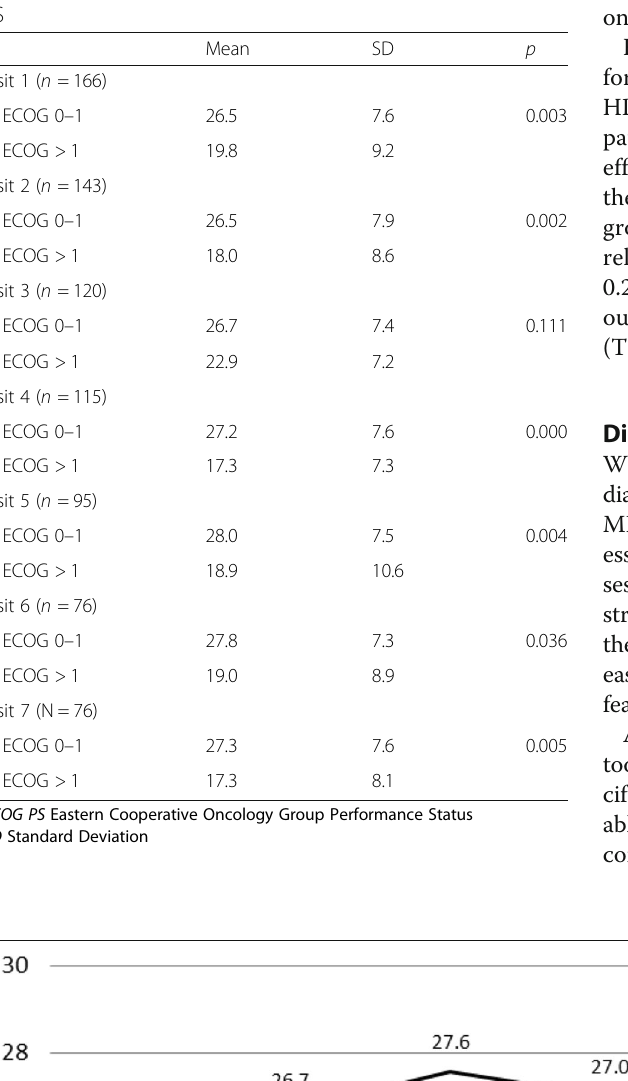
Table 3 BOMET-QoL-10 scores throughout the study by ECOG